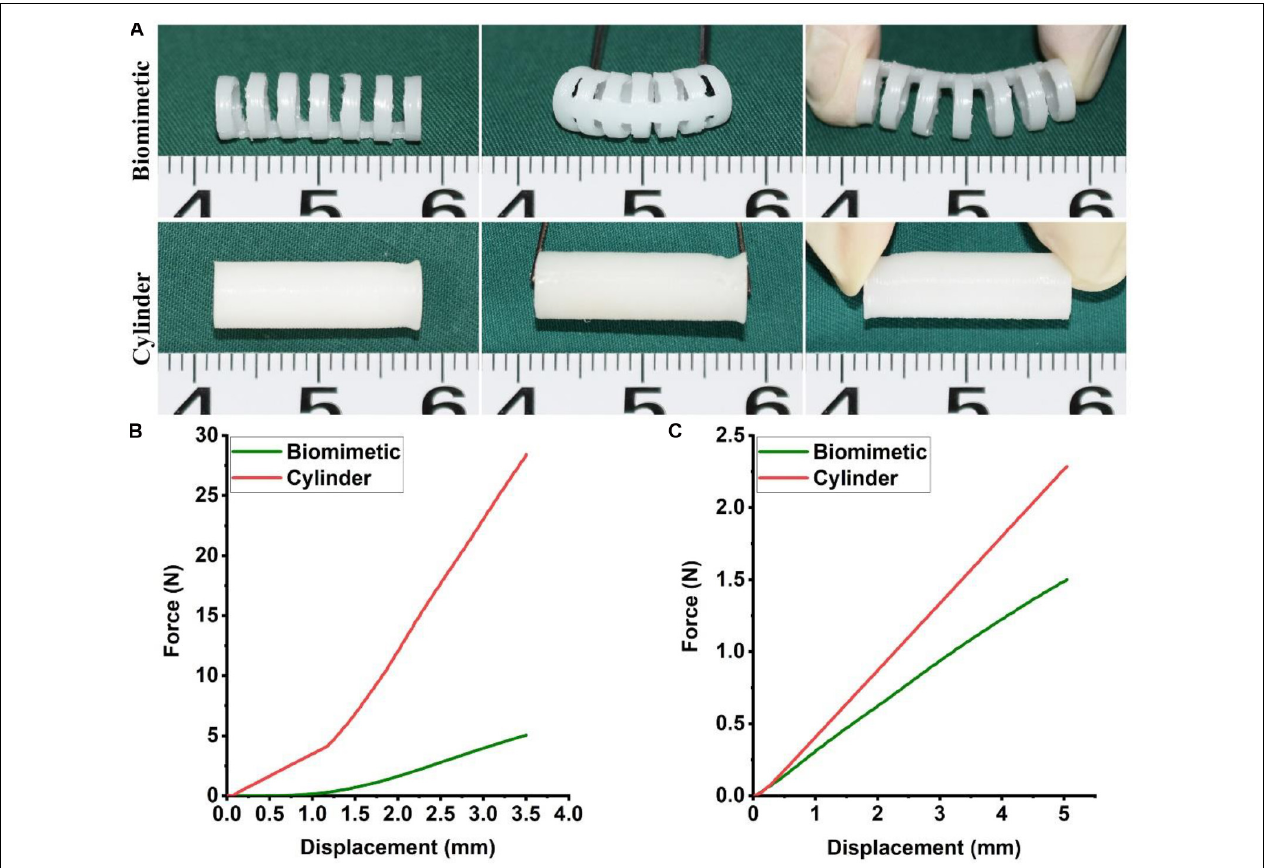
FIGURE 1 | Mechanical properties of the biomimetic PCL scaffold. Bending and extending tests of the biomimetic PCL scaffold and the cylindrical PCL tube (A) . Three-point bending (B) and compression test (C) of the biomimetic PCL scaffold and the cylindrical PCL tube ( N = 3 per